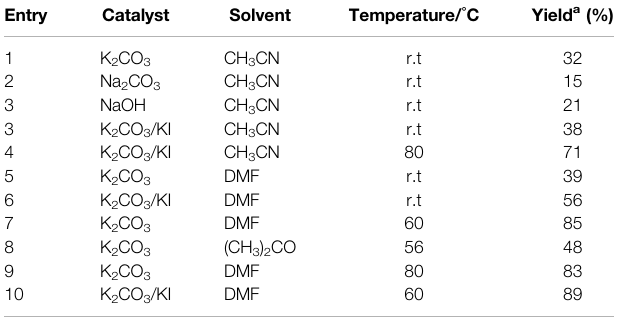
TABLE 1 | The reaction conditions for compound A1 were optimized.